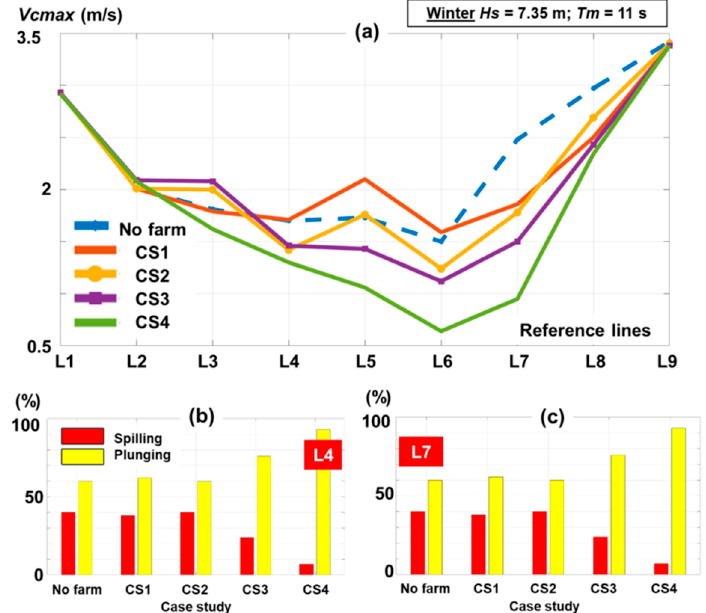
Figure 14. Evaluation of the nearshore processes considering a high energy winter event (winter B), where: ( a ) maximum nearshore current velocities (in m / s) along the reference lines; ( b ) and ( c ) balance between the wave spilling and plunging along the lines L4 and L7, in percentage.